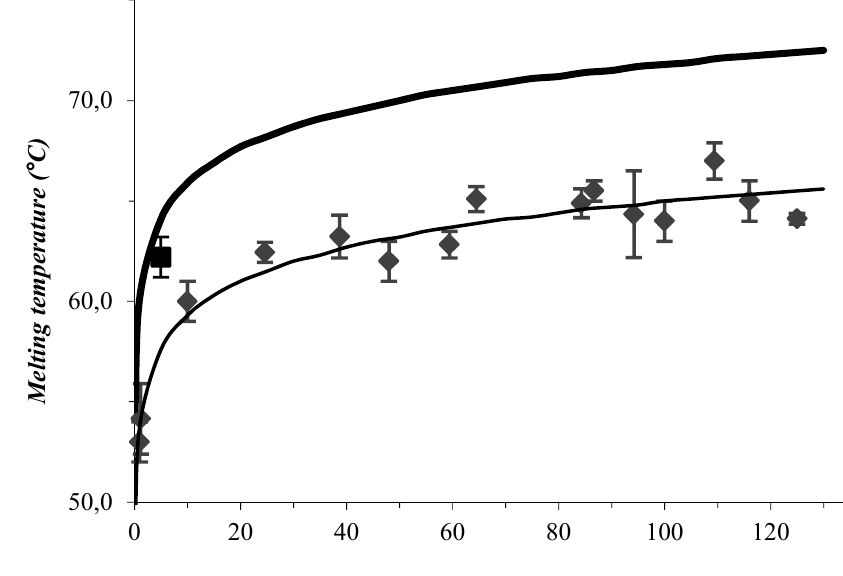
Figure A4. Mean value of melting temperature and a confidence interval of 95% in a 100 mM NaCl(diamond), melting temperature in a 500 mM NaCl (square), predicted melting temperature in a 100 mM NaCl (plain) and predicted melting temperature in a 500 mM (bold) of the pairing between strands A concentration. Prediction were made with OligoCalc [46].